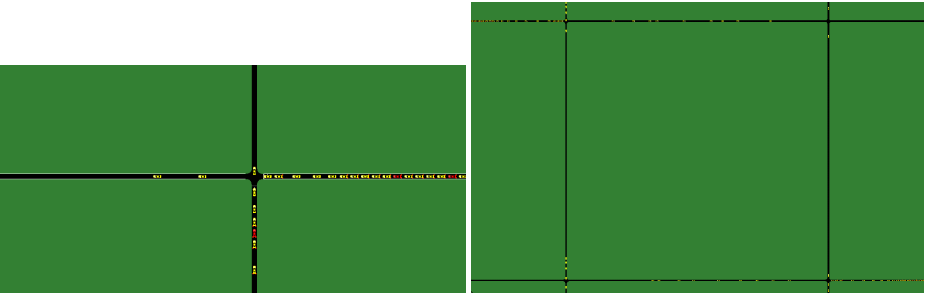
Figure 1. Left : SUMO simulator showing an intersection with regular vehicles (yellow) and emergency vehicles (red). Right : SUMO simulator showing the representation of a city with 2 2 ×